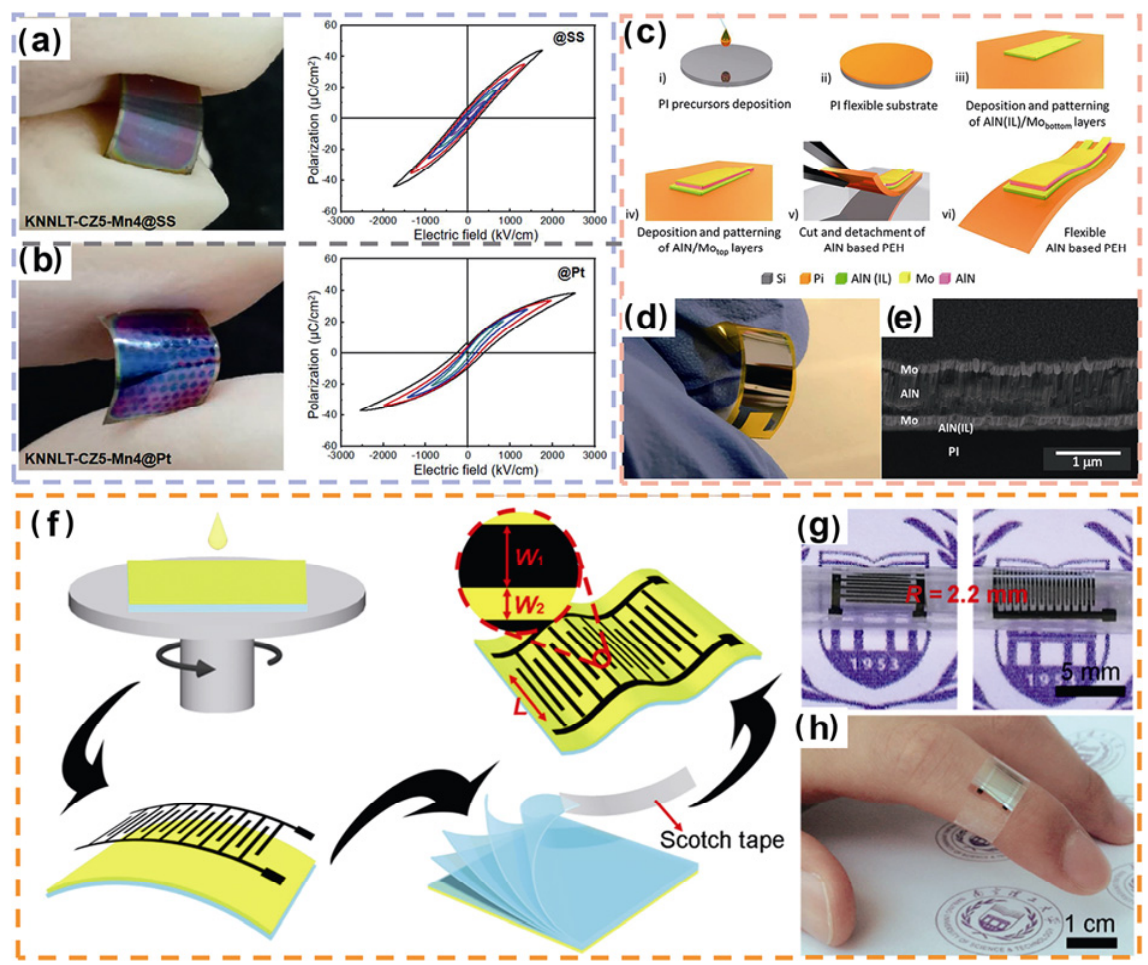
Fig. 7 Polarization–electric field ( P – E ) hysteresis loops for flexible (a) KNNLT–CZ5–Mn4@SS and (b) KNNLT– CZ5–Mn4@Pt thin films. (c) Schematic illustration of overall fabrication for AlN-based flexible piezoelectric energy harvester (FPEH). (d) Photograph of AlN-based device bent by fingers. (e) SEM image illustrating the cross-section view of the FPEH. (f) Schematic diagrams of fabrication process of mica-based FPEH. Photographs of FPEH attached on (g) glass tube with R = 2.2 mm and (h) finger to show wearability. Reproduced with permission from Ref. [40] for (a, b), © American Chemical Society 2021; Ref. [165] for (c–e), © American Chemical Society 2018; Ref. [158] for (f–h), © Elsevier Ltd.